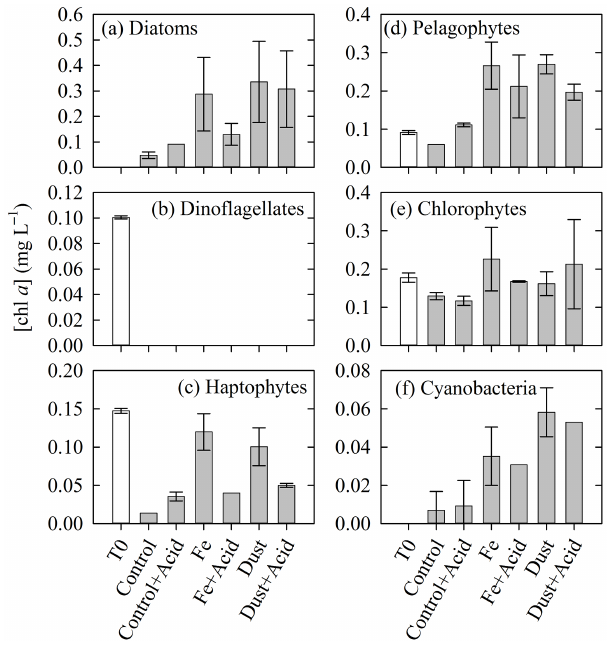
Figure 3. Average chl a concentration (µgL − 1 ) attributable to each of the measured groups of phytoplankton initially (T0: white bar) and for each of the treatments after 4 days (T4) of incuba- tion (Control, Control + Acid, Fe, Fe + Acid, Dust, Dust + Acid; gray bars). Panel (a) : diatoms; panel (b) : dinoflagellates; panel (c) : haptophytes; panel (d) : pelagophytes; panel (e) : chloro- phytes; panel (f) : cyanobacteria. Error bars indicate standard de- viations. n = 2 except for T0 (all groups but dinoflagellates), where n = 3, and Acid, diatoms, Control, haptophytes and pélago- phytes, Dust + Acid, cyanobacteria and Fe + Acid, haptophytes, and cyanobacteria, where n = 1.